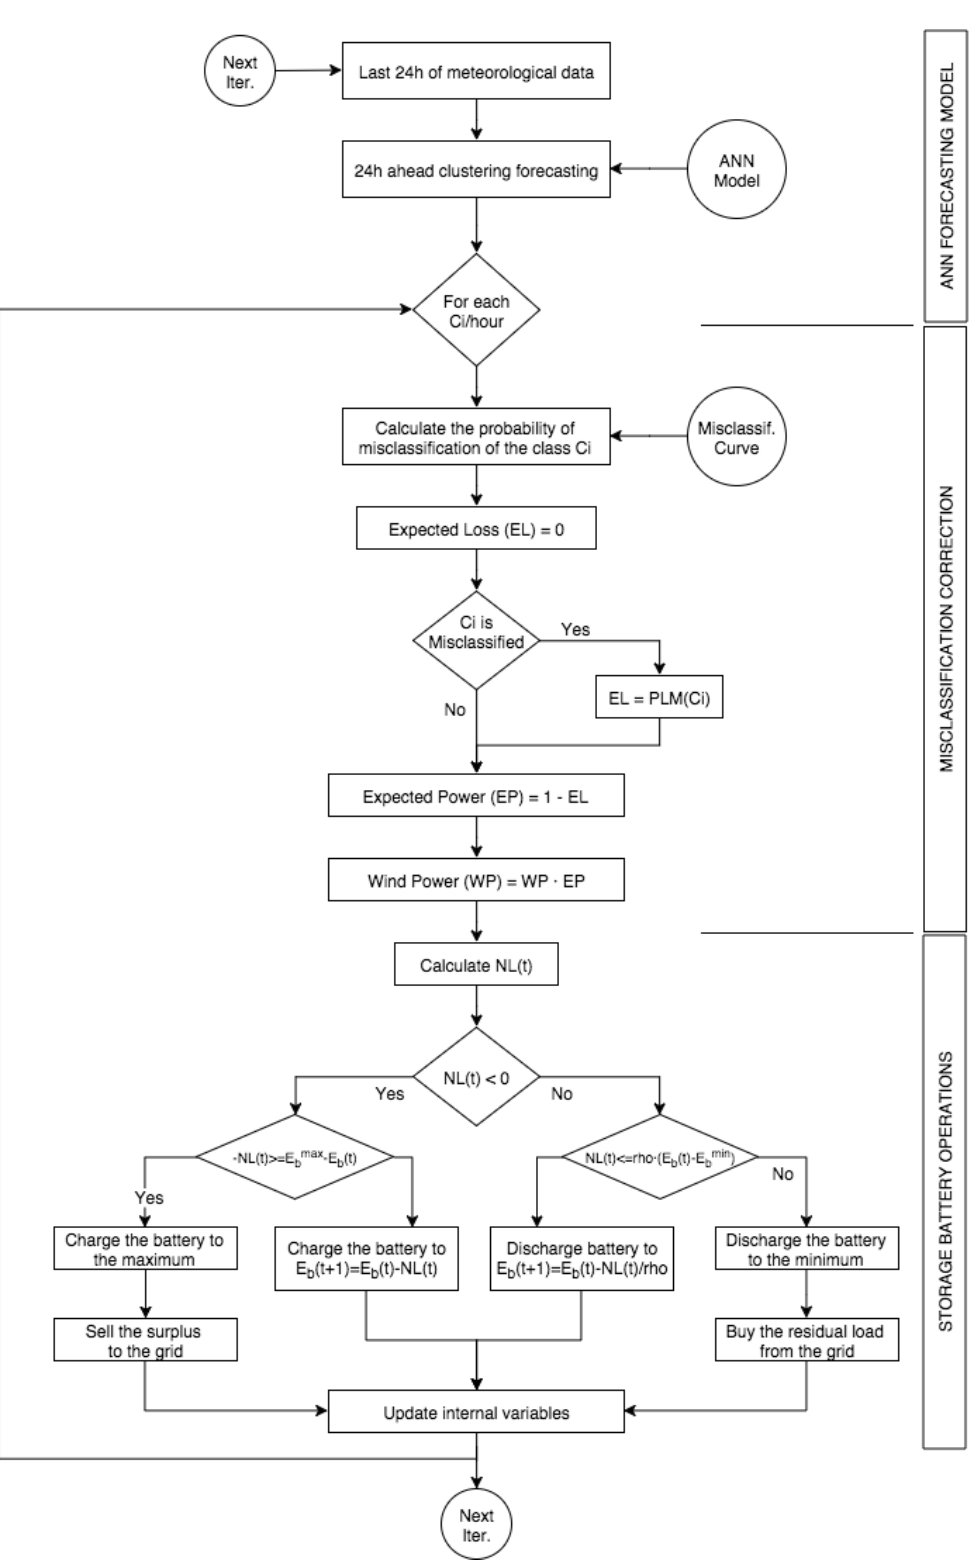
Figure 2. Monte Carlo simulation workflow: The simulation is divided into three stages: (1) power output forecast using artificial neural network (ANN); (2) misclassification correction; and, (3) battery storage operations.